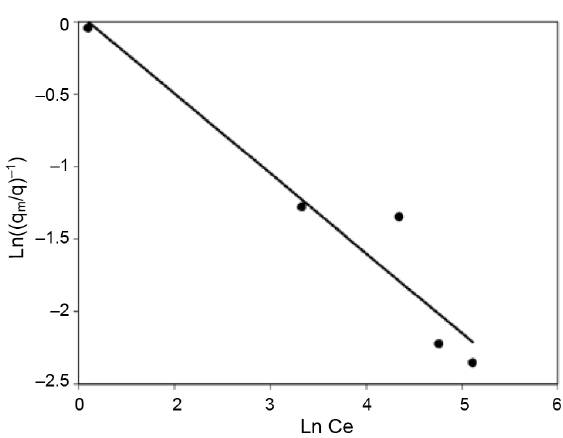
Fig. 6. Generalized biosorption isotherm plot of ln (( q m / q ) −1 ) vs. ln C e The m q value was taken as m q = 81.3 mg g